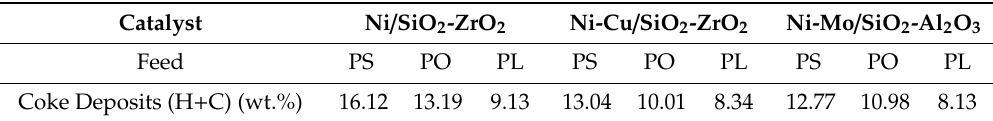
Table 7. Coke deposited onto the catalysts surface after their use in hydrotreatment of di ff erent feeds (PS, PL and PO). Catalyst Ni / SiO 2 -ZrO 2 Ni-Cu / SiO 2 -ZrO 2 Feed PS PO PL PS PO PL PS PO PL Coke Deposits (H + C) (wt.%)